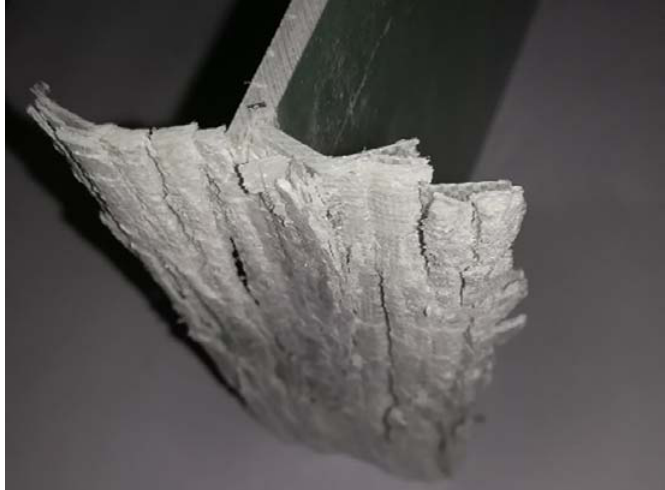
Figure 6: Detail of the crushed part of a glass fiber specimen